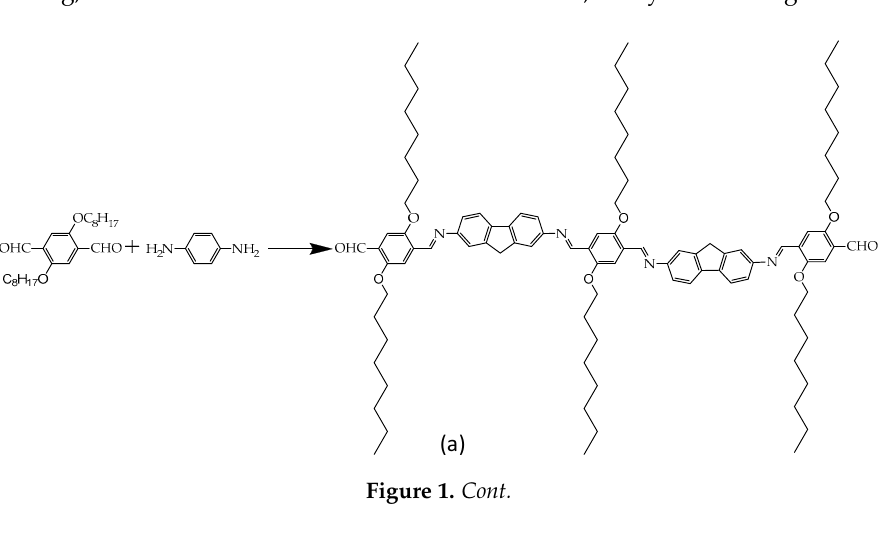
Figure 1. Synthesis of conjugated oligophenyleneimines: ( a ) DAFCHO; and ( b ) FDACHO. FT-IR spectroscopy was used to characterize the DAFCHO and FDACHO oligomers (Figure 2). The results show the emergence of vibrational bands at 3050 cm − 1 and 3052 cm − 1 , corresponding to the aromatic C-H bonds. The vibrational bands at 2919 cm − 1 , 2851 cm − 1 , 2923 cm − 1 and 2854 cm − 1 , corresponding to the (C-H) of aldehyde (CHO), methylene (CH 2 ) and methyl (CH 3 ) groups, originate from the aliphatic chains. The vibrational bands at 1594 and 1579 cm − 1 are linked to the vibration of the groups (C=C), while the vibrational bands at 1680 and 1682 cm − 1 emerge due to the (C=O) bond, generated by the terminal aldehyde groups (CHO). Finally, the formation of the imine bonds (C=N) were observed at 1613 and 1610 cm − 1 .